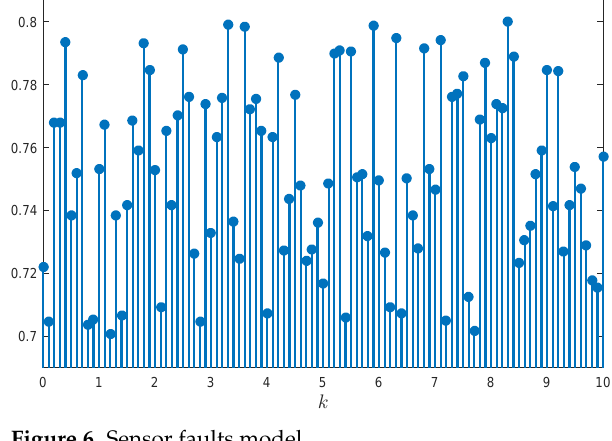
Figure 6. Sensor faults model.